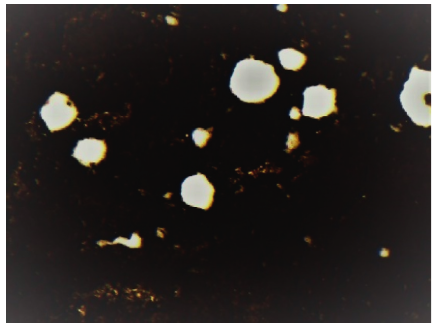
Figure 9: Bubble imaging of GO3 after 100 salt-frost cycles.